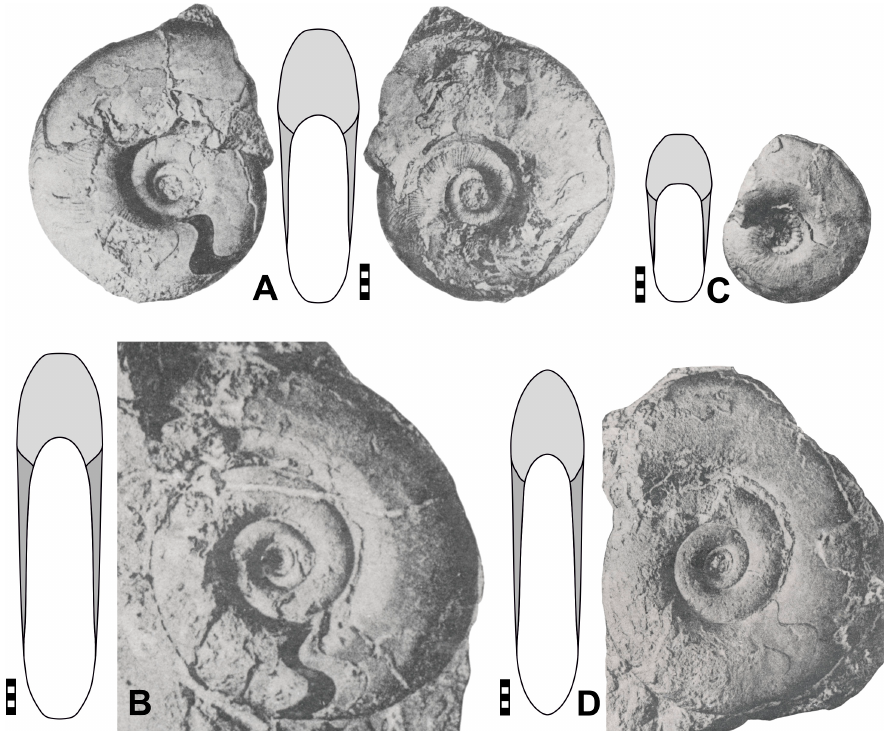
Fig. 4. Specimens of Pseudoprobeloceras Bensaïd, 1974 and Ponticeras Matern, 1929; reproductions from Wedekind (1918). A . Pseudoprobeloceras pernai (Wedekind, 1918), lectotype SMF.Mbg.2322 (Welsch 1912 Coll.) from Oberscheld (Prinzkessel Mine). B . Pseudoprobeloceras applanatum (Wedekind, 1918), holotype SMF.Mbg.2323 (Welsch Coll.) from Oberscheld (Prinzkessel Mine). C . Pseudoprobeloceras pernai (Wedekind, 1918), holotype SMF.Mbg.2326 (Welsch 1913 Coll.) of “ Gephyroceras Barroisi ” from Oberscheld (Prinzkessel Mine). D . Ponticeras aequabile (Beyrich, 1837), holotype SMF.Mbg.2324 (Meuhsen 1855 Coll.) of “ Gephyroceras Kayseri ” from Oberscheld (Königszug Mine). Scale bar units = 1